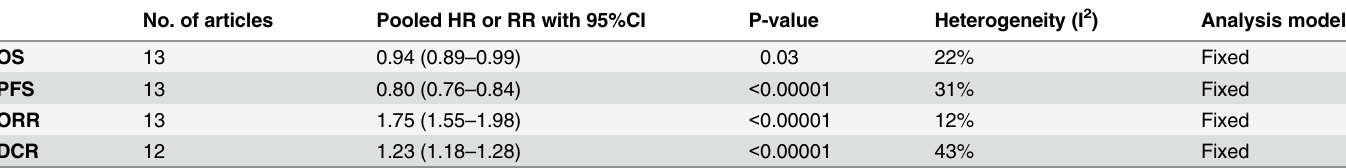
Table 2. Summary of the pooled results and corresponding